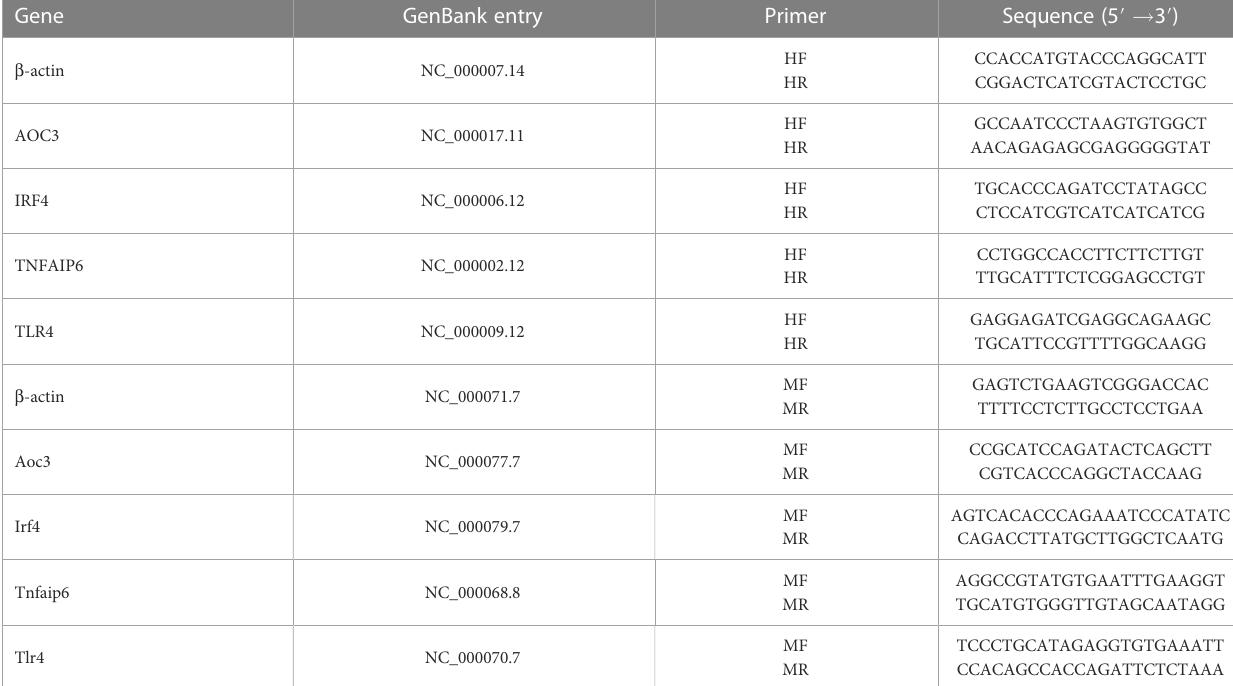
TABLE 2 The primers used for PCR. Gene GenBank entry